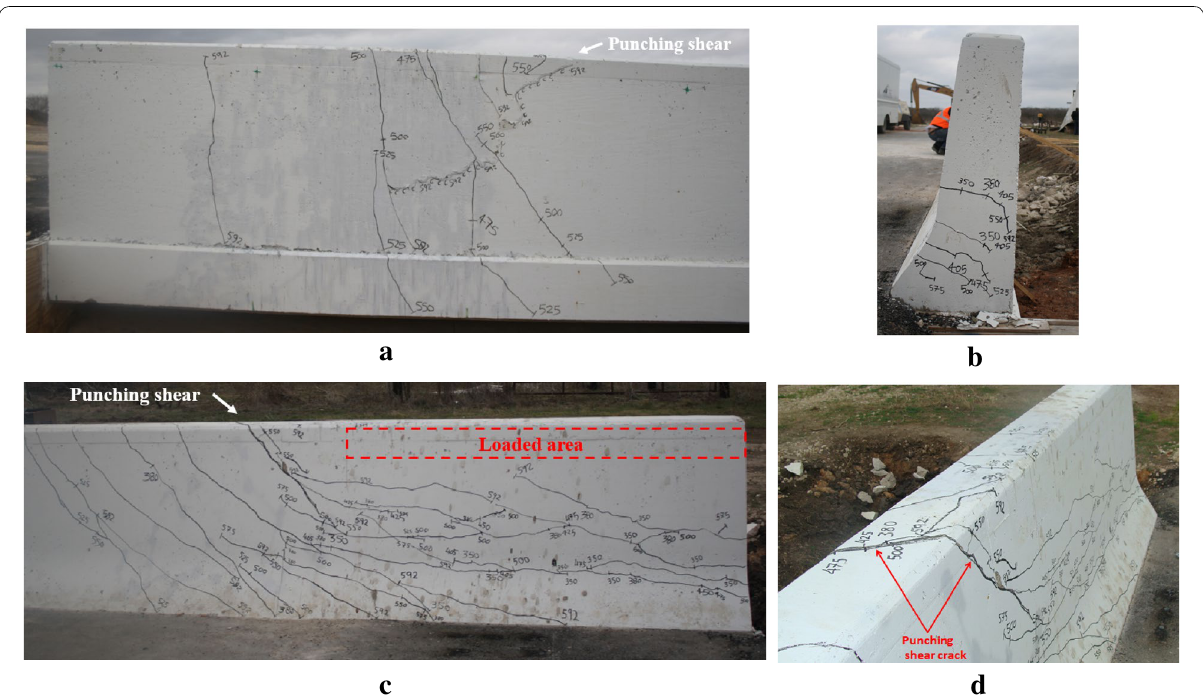
Fig. 6 Crack pattern at end location of the barrier wall. a Crack patter at back face of the barrier, b flexural cracks at end face of the barrier, c crack pattern at front face of the barrier, d punching shear through barrier